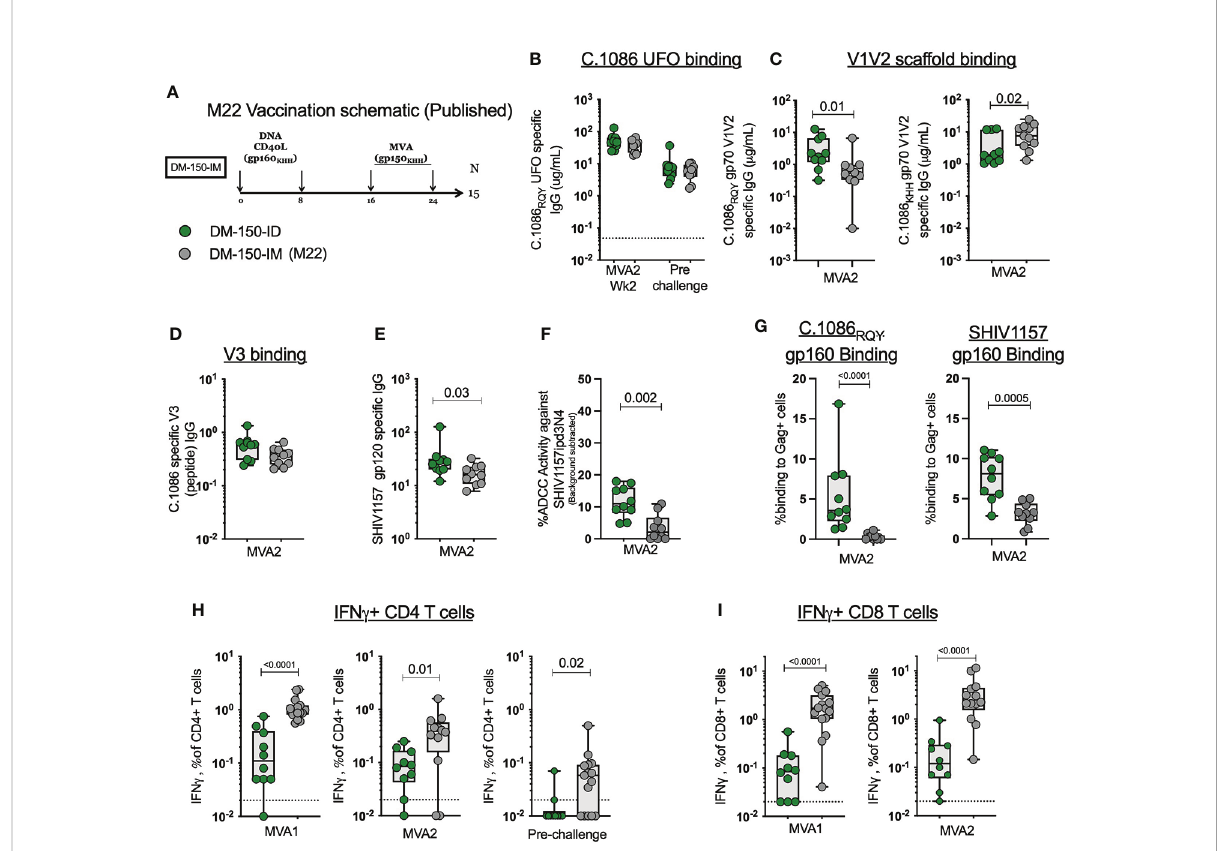
FIGURE 5 ID immunization dampens the immunogenicity of the antigen speci fi c B and T cell response compared to IM immunization. (A) Published M22 vaccination schematic. (B) MVA2 and prechallenge binding antibody responses to C.1086 RQY UFO protein (C) C.1086 wt and mutated V2 HS gp70 V1V2 binding antibody responses. (D) C.1086 V3 binding antibody responses. (E) SHIV1157ipd3N4 gp120 binding antibody responses. (F) ADCC activity against the challenge virus SHIV1157ipd3N4. (G) Binding of serum antibody post MVA2 to 293 T cells transfected with DNA/SHIV C.1086 or DNA/SHIV SHIV1157ipd3N4. (H) Total SHIV speci fi c IFN g + CD4 T cell response post MVA1, MVA2, and prechallenge. (I) Total SHIV speci fi c IFN g + CD8 T cell response post MVA1 and